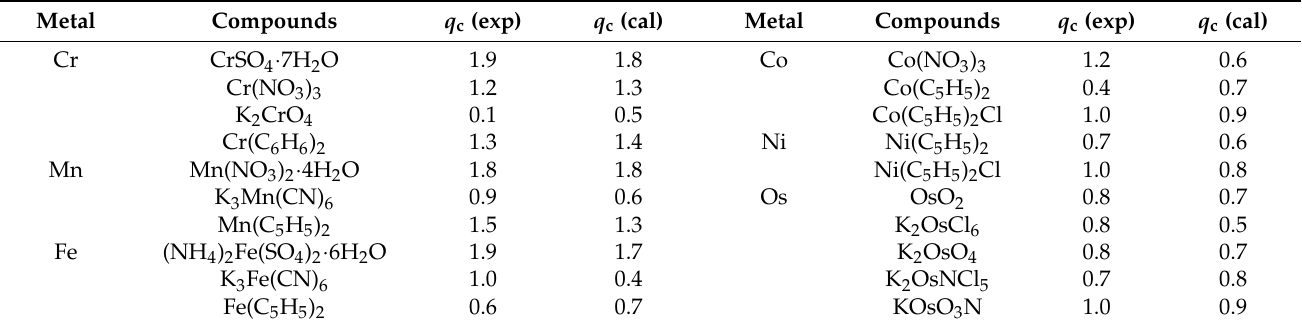
Table 11. Coordination effective charges of metals in